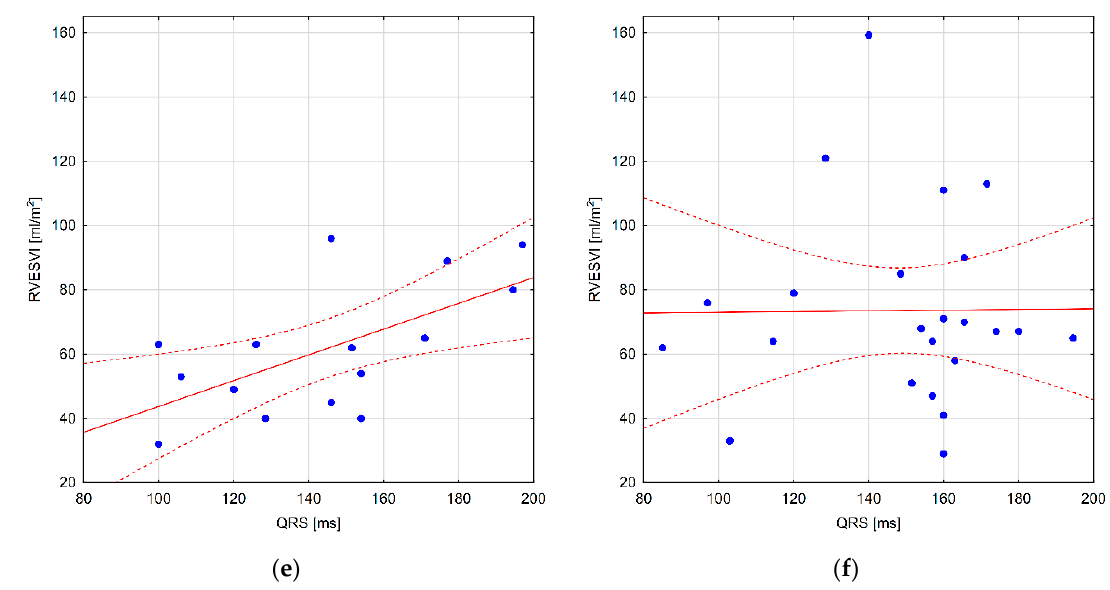
Figure 3. Scatter charts showing the relationship between QRS duration and the CMR parameters: ( a ) right ventricular ejection fraction (RVEF) in patients after early repair; the Spearman correlation coefficient is significant (r = − 0.61); ( b ) RVEF in patients after late repair; no substantial correlation was observed ( p > 0.05); ( c ) right venricular end-diastolic volume index (RVEDVI) in patients after early repair; the Spearman correlation coefficient is significant (r = 0.56); ( d ) RVEDVI in patients after late repair; no substantial correlation was observed ( p > 0.05) ( e ) right venricular end-systolic volume index (RVESVI) in patients after early repair; the Spearman correlation coefficient is significant (r = 0.54); ( f ) RVESVI in patients after late repair; no substantial correlation was observed ( p > 0.05). Solid line represents linear regression and the dotted lines stand for regression tolerances.